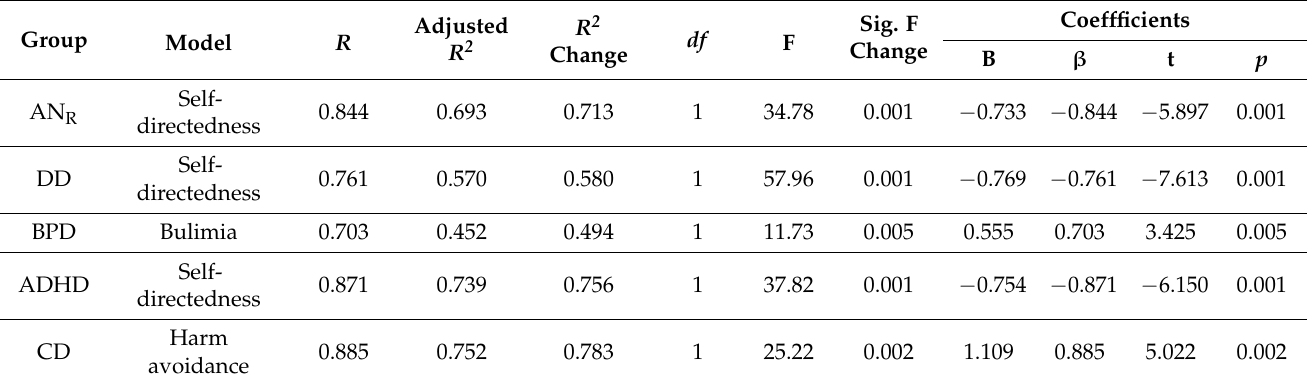
Table 6. Hierarchical linear regression analysis with stepwise selection (identity diffusion = dependent variable) in mental-disorder groups. B = unstandardized beta, β = standardized